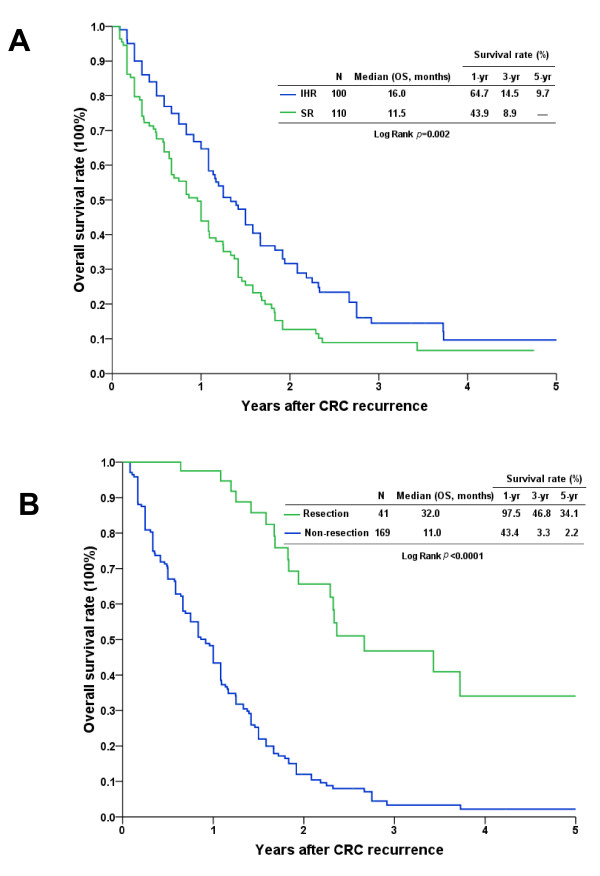
Kaplan-Meier cumulative survival curves of patients who underwent liver resection for hepatic metastasis after colorectal cancer recurrence. A. The survival curve of patients with intrahepatic recurrence (IHR) was relatively better than that of patients with systemic recurrence (SR) (p = 0.002). B. Patients who had undergone surgical resection of recurrent lesions had a better survival curve than did patients without resection (p < 0.0001).